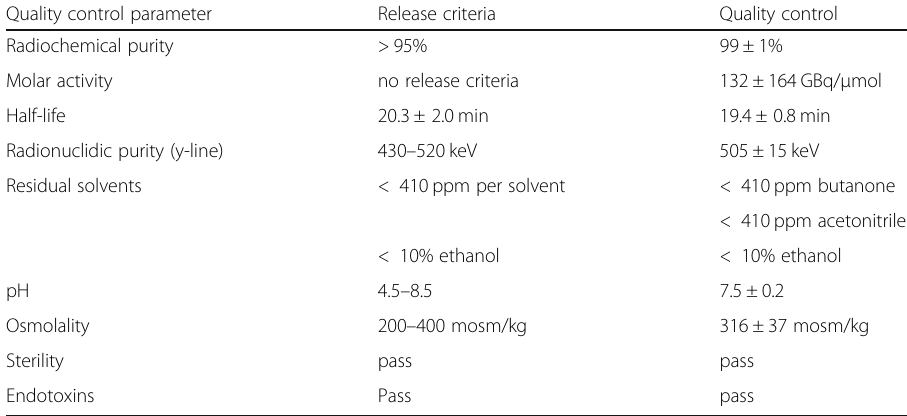
Table 2 Quality control parameters for all released batches ( n = 81) of [ 11 C]metoclopramide according to the recommendations of the European Pharmacopoeia for 11 C-radiotracers Quality control